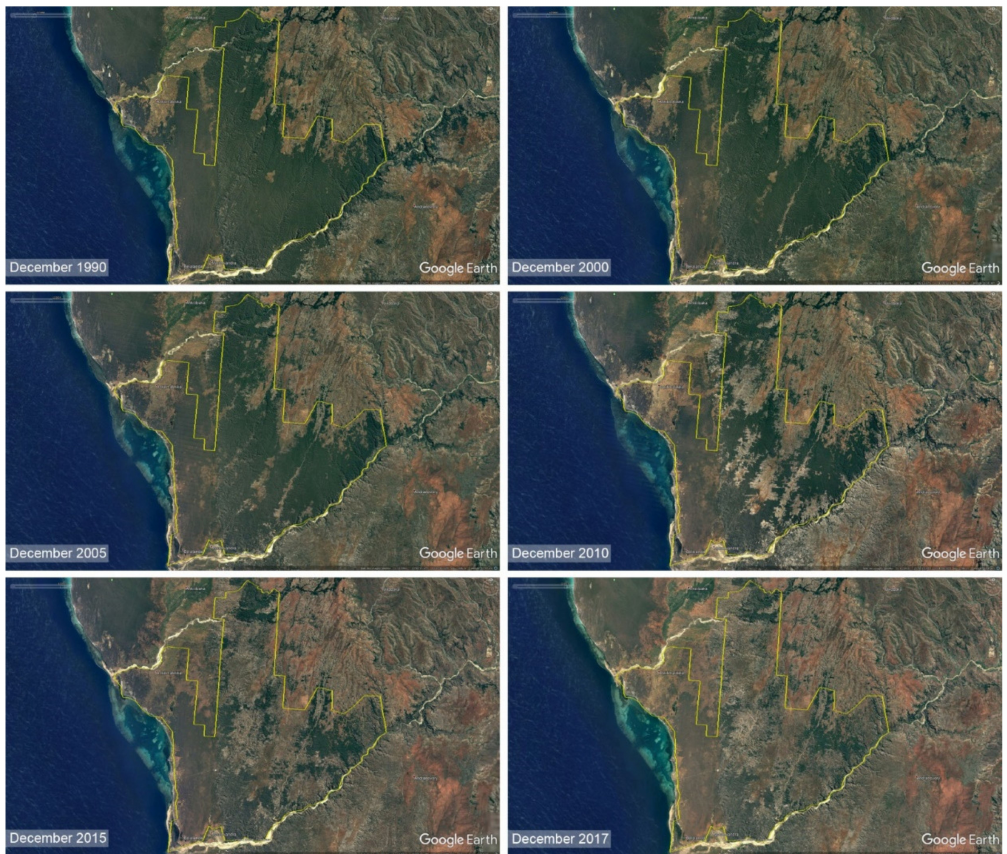
Figure 5. Deforestation for the six years of study at Ranobe PK-32. (Google Earth images, see online for a complete year-by-year time series) with the following link https://earthengine.google.com/timelapse/#v=-23.12537,43.27126,7.217